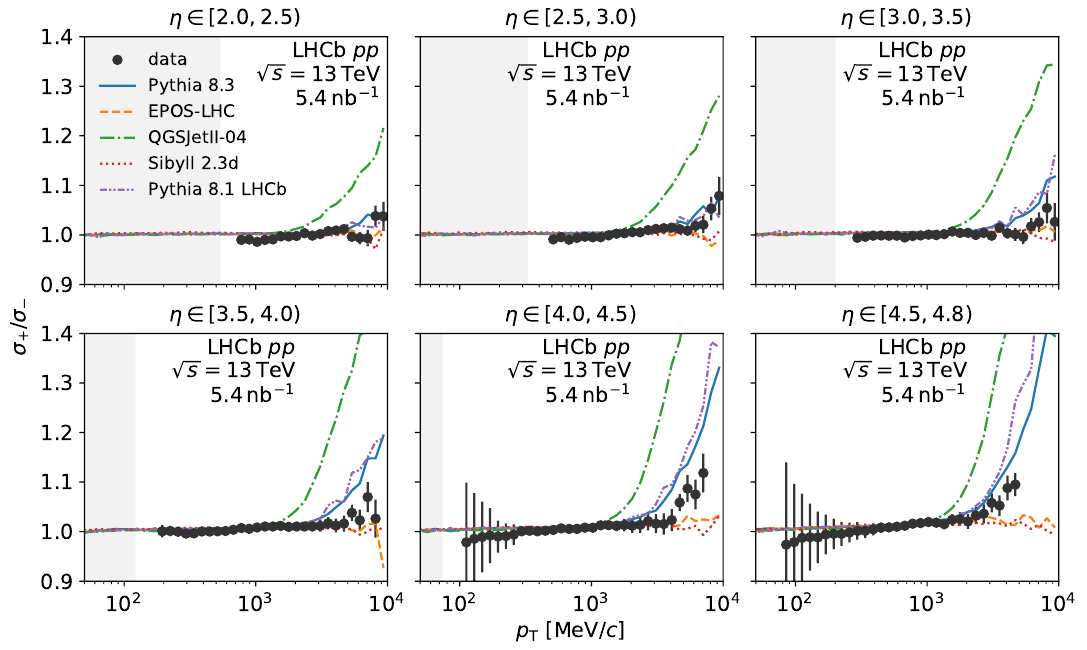
Figure 11 . Ratios of the differential cross-sections of inclusive production of prompt long-lived positively and negatively charged particles as a function of transverse momentum and pseudorapid- ity for the data and the models shown in figure